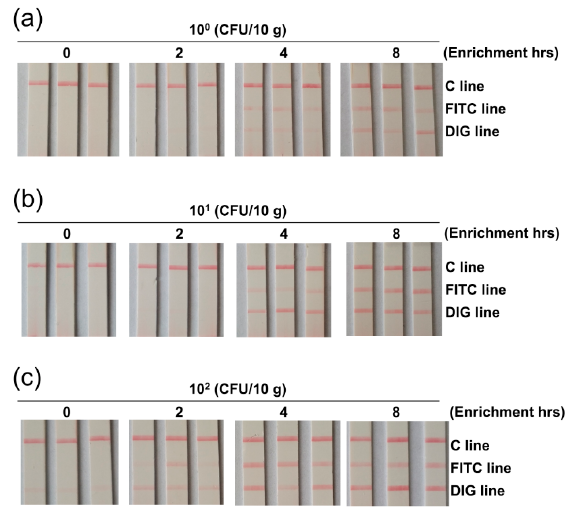
Figure 5. Limit of detection in spiked food samples. The image shows the detection results of the duplex RPA-LFS biosensor for spiked food samples. The spiking amounts were 10 0 ( a ), 10 1 ( b ), and 10 2 ( c ) CFU of the mix of V. cholerae and V. vulnificus per 10 g of shrimp. The enrichment time (in hours) after spiking was indicated on top of the strips. The triplicate strips represented results from three independent